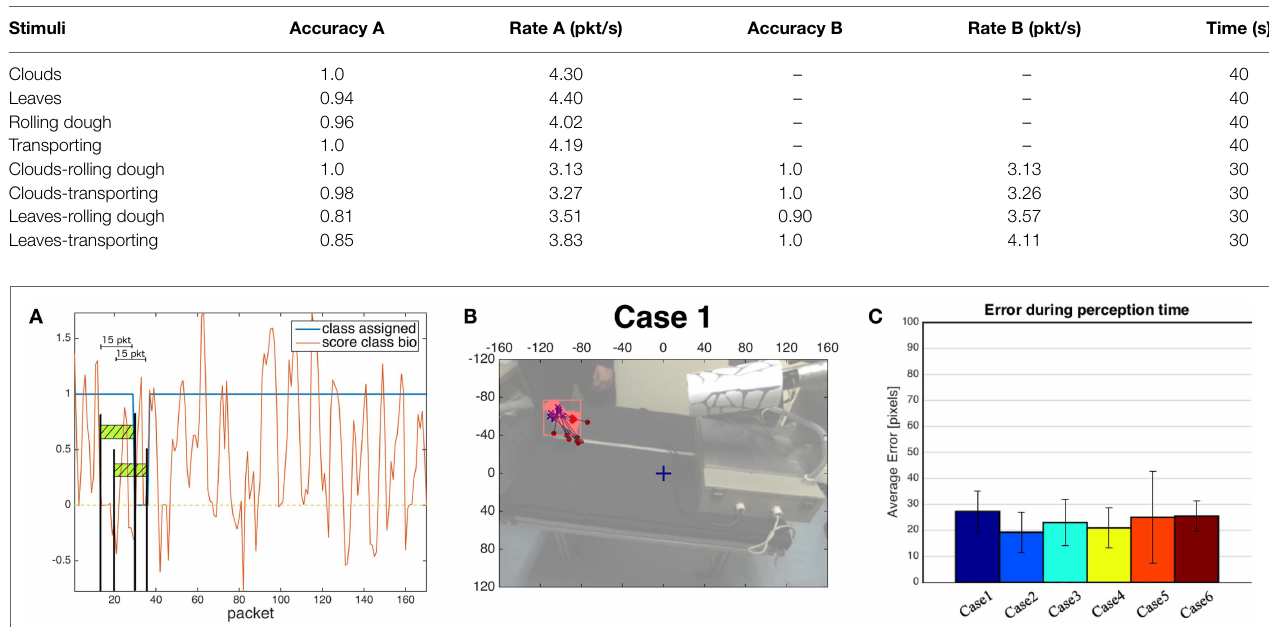
TABLE 3 | Online classification results with one stimulus and two stimuli . Stimuli